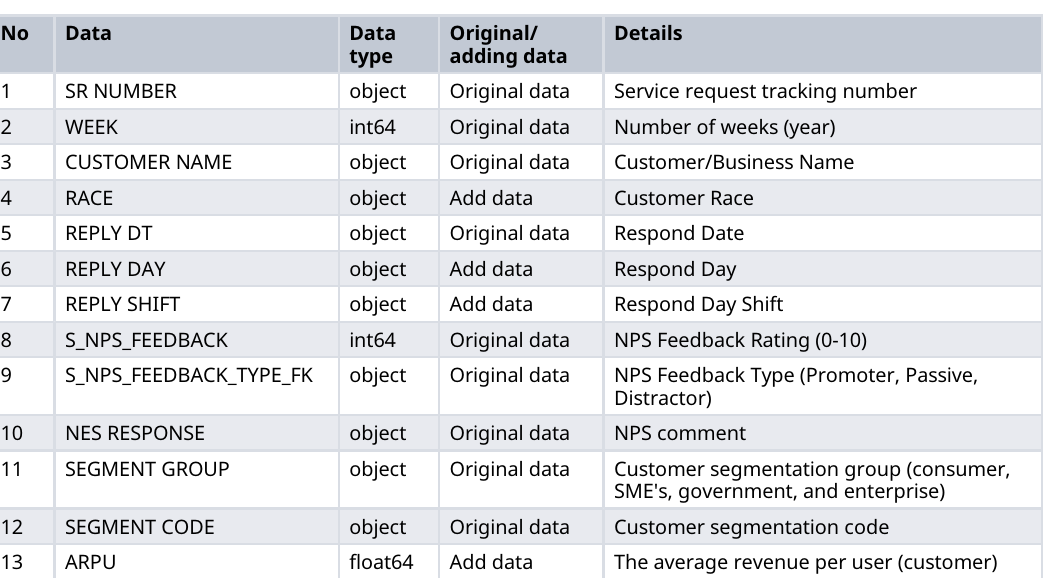
Table 10. Dataset